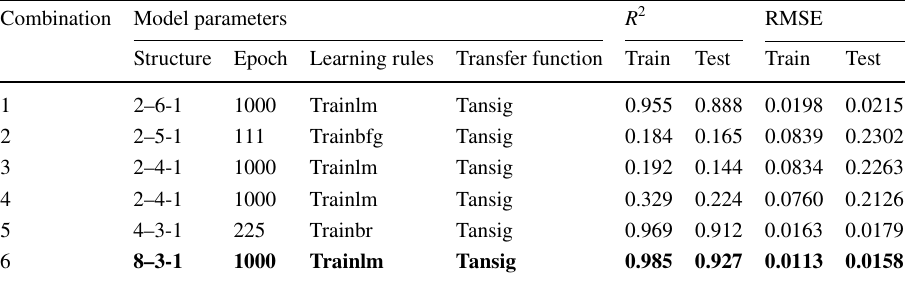
Bold values represent the